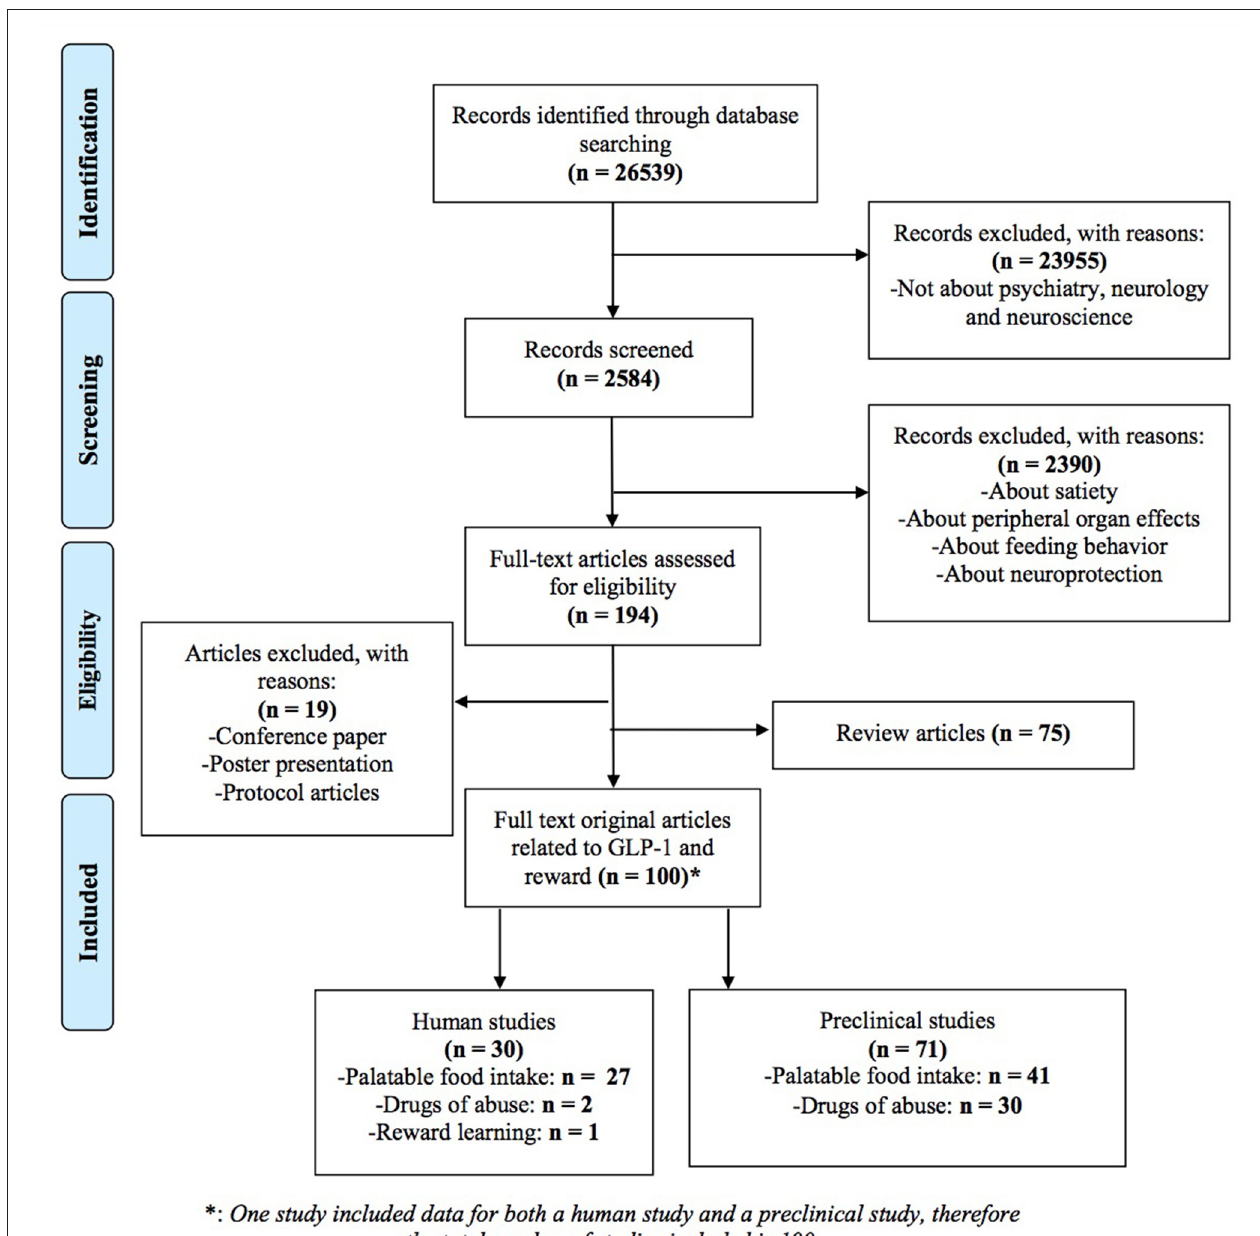
FIGURE 1 | The PRISMA flow diagram of the search strategy.